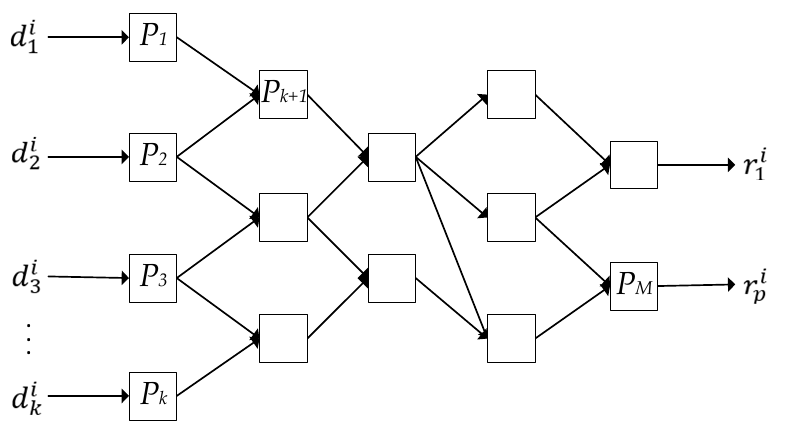
Figure 5. The proposed multi-pipeline computational structure.